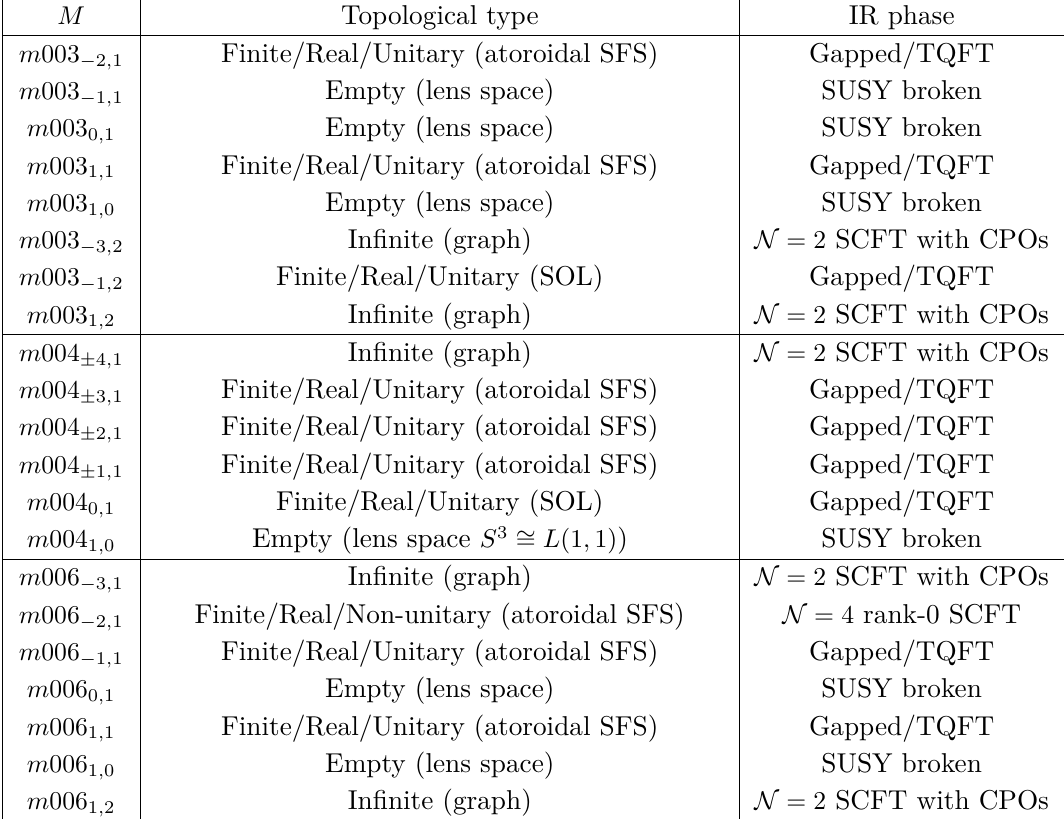
Table 3. Topological types of non-hyperbolic 3-manifolds obtained by exceptional Dehn fillings and the IR phases for the associated class R theories. Here N . Refer to [8] for the topological types of the non-hyperbolic 3-manifolds in the N PA SP + QB SP conventional mathematical classification scheme ( continues